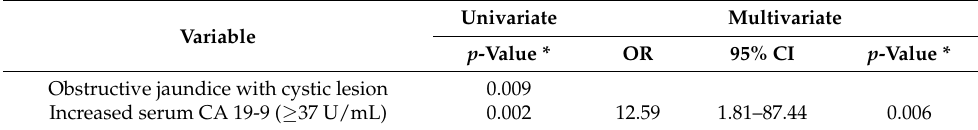
Table 3. Factors associated with IC in patients with high-risk lesion.